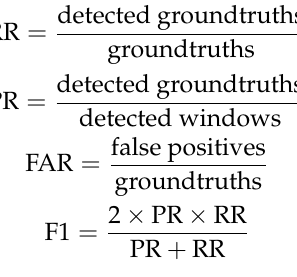
Table 1. Training and test images.